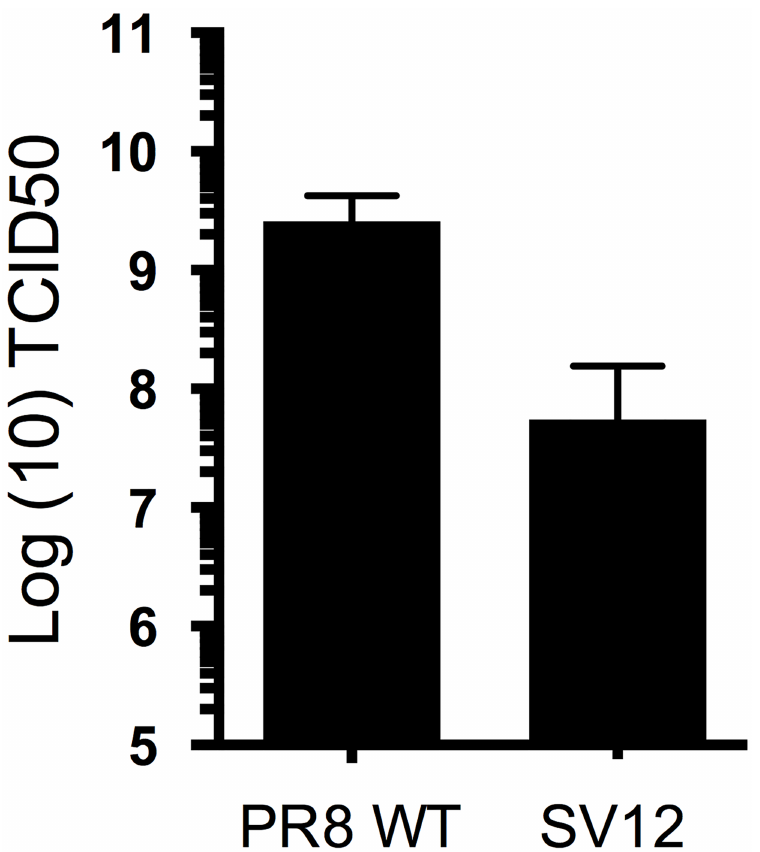
Fig 1. Fitness tradeoff associated with the accumulation of antigenic escape substitutions in HA. Growth of plaque purified biological clones of PR8 WT and SV12 was compared in eggs. Eggs were infected in triplicate with 500 TCID50 of the indicated virus. 48 hours later, viral loads in allantoic cavities were titered by TCID50